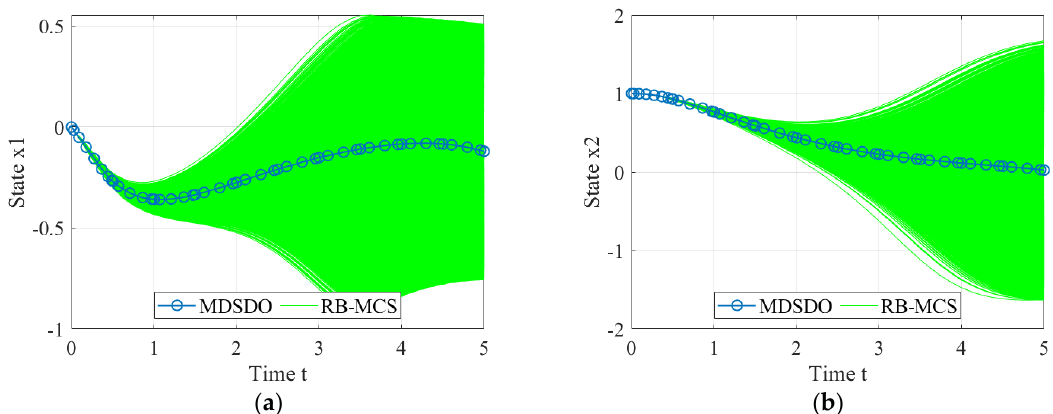
Figure 6. The uncertainty influence on state trajectories under MDSDO. ( a ) State trajectories of x 1 . ( b ) State trajectories of x 2